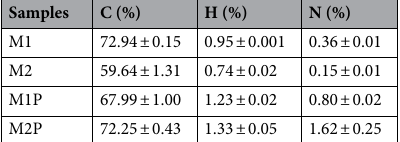
Table 1. The elemental composition of prepared hybrids as determined by EDX-XRF method.